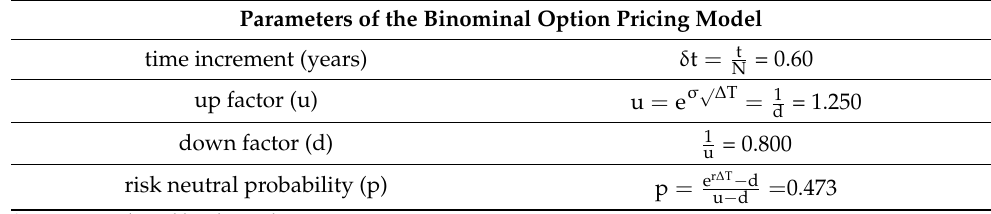
Table 4. Recombining binomial lattice parameters (Samsung’s acquisition of